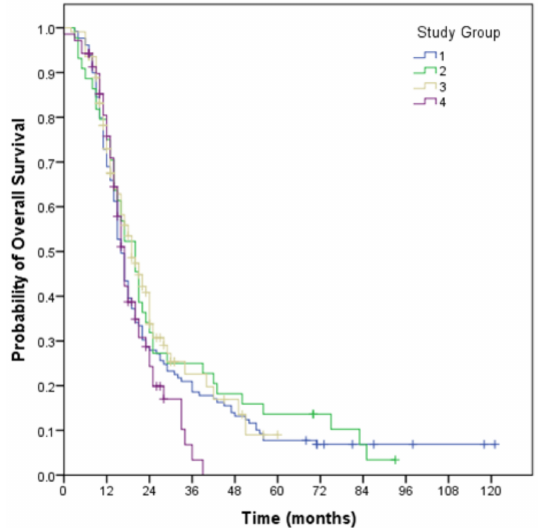
Figure 2. Overall survival for geographical Groups 1–4. (Group 1: Metropolitan centre pre-2013; Group 2: Regional residents managed pre-2013 at the metropolitan centre; Group 3: Metropolitan centre post-2013; Group 4: Regional residents managed post-2013 at the regional centre). Table 2. Survival for favourable prognostic factors within geographical Groups 1–4.